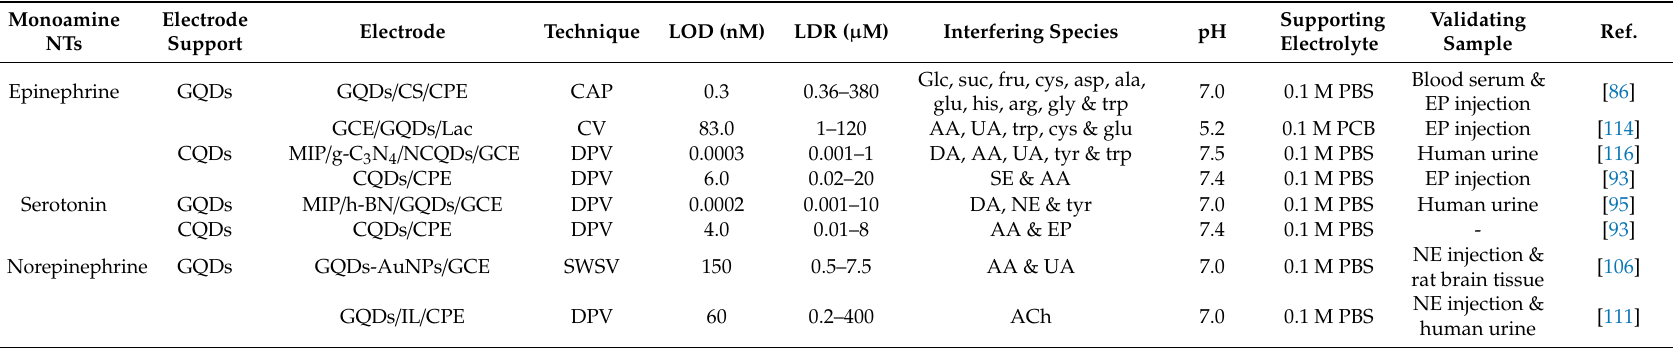
Table 3. Table of the figures of merit of other monoamine NTs (EP, SE and NE) determination using graphene and carbon quantum dots (GQDs &